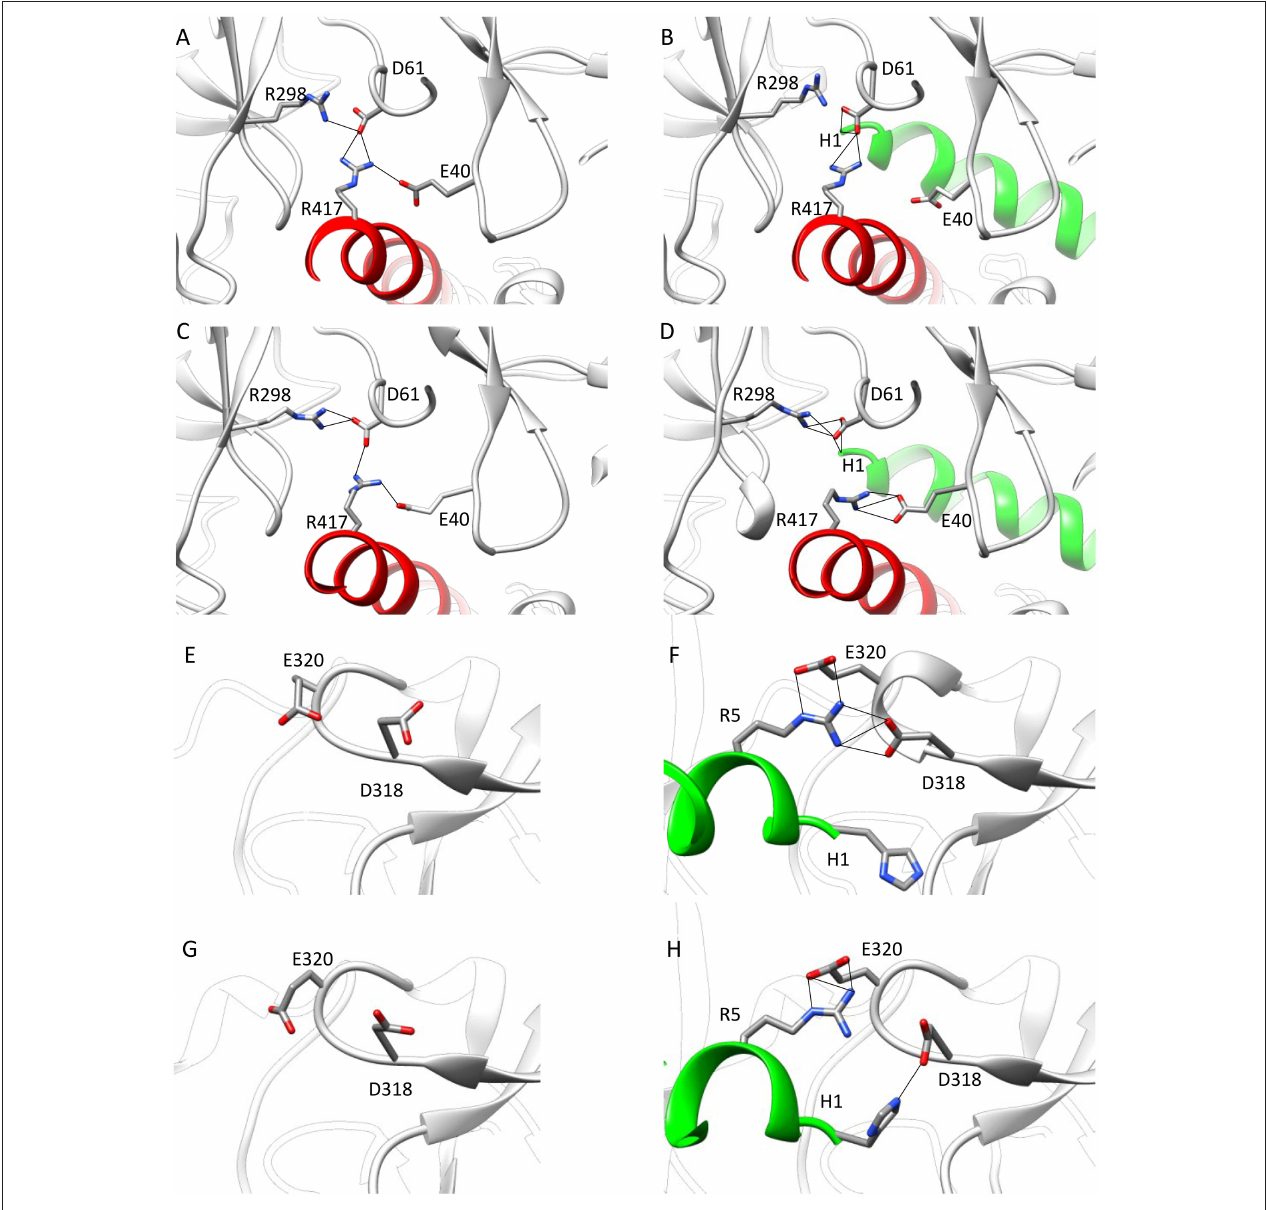
FIGURE 4 | Interaction networks in NTR and CM2. (A–D) the NTR hydrogen bond network E40-R417-D61-R298. (A,B) Closed state of NTR. The interactions between E40 and R417 (A) are disrupted by introduction of DP cpvtN2 (B) . (C,D) Open state of NTR. Interaction between R417 and D61 (C) are disrupted but interaction between D61 and R298 is strengthened by introduction of DP cpvtN2 (D) . (E–H) the CM2 hydrogen bonding network. (E,F) closed state of NTR; (G,H) open state of NTR. A hydrogen bonding network is formed in CM2 (F,H) between D318 and E320 from domain B and H1 and/or R5 from DP cpvtN2 . The central helix is shown in red; DP cpvtN2 is shown in